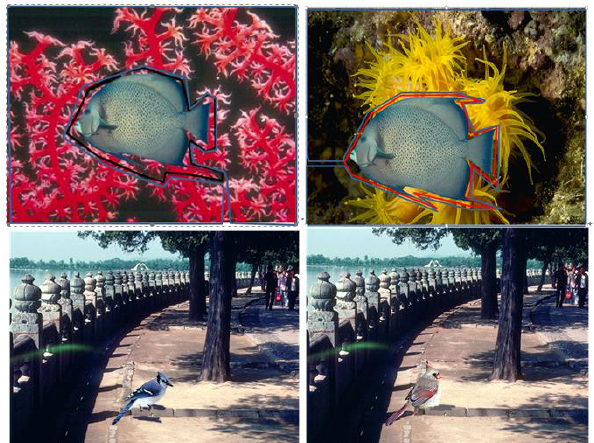
Figure 1. Sample pictures presented in the study (pictures were from Chua et al. (2005) with the author’s consent for research use) Note: The left column was from learning phase and the right column was from recognition phase. For detail, the upper right picture was the original focal object with a new back- ground, and the bottom right was the new focal object with an old background. The focal objects in the sample pictures were the fish and the bird. For the upper left picture, the fish with black line marked out was the interest area of focal object